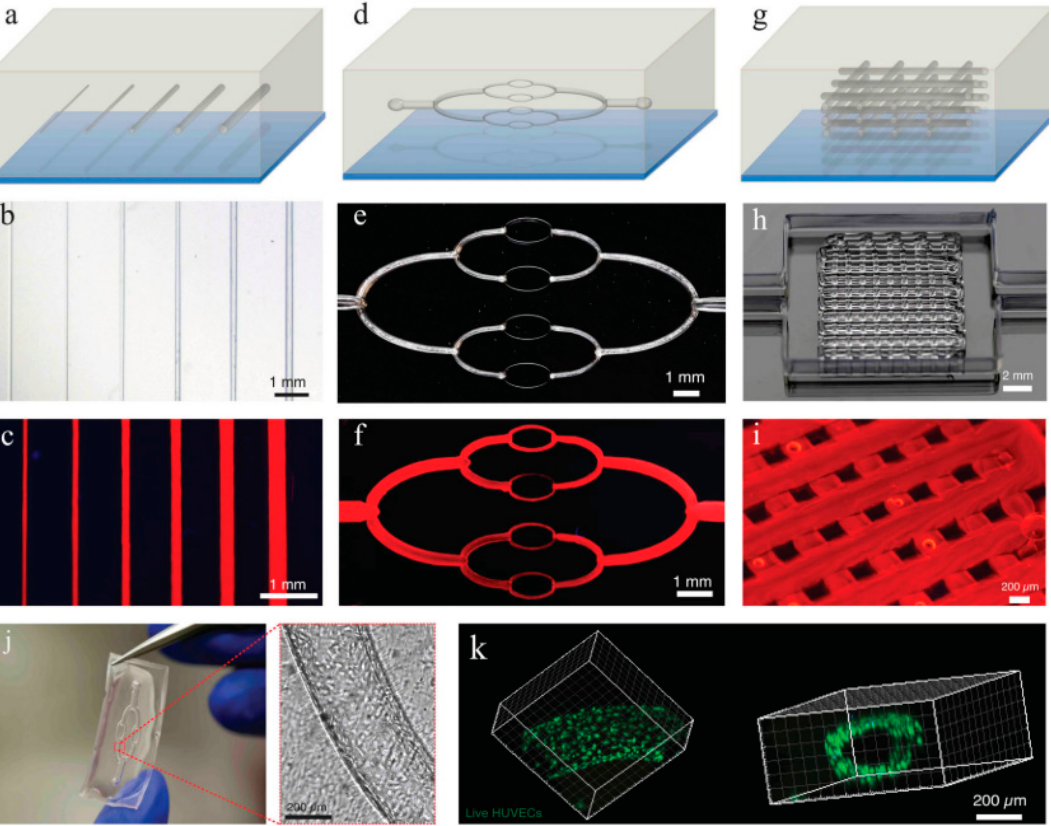
Figure 3. Bioprinted vascular networks perfused with fluorescent dye in: 1D ( a – c ); 2D ( d – f ); and 3D ( g – i ). HUVECS embedded into the 2D vascular network ( j ); and aligned to the walls ( k ). Reprinted from Reference [81], with permission from John Wiley and Sons.